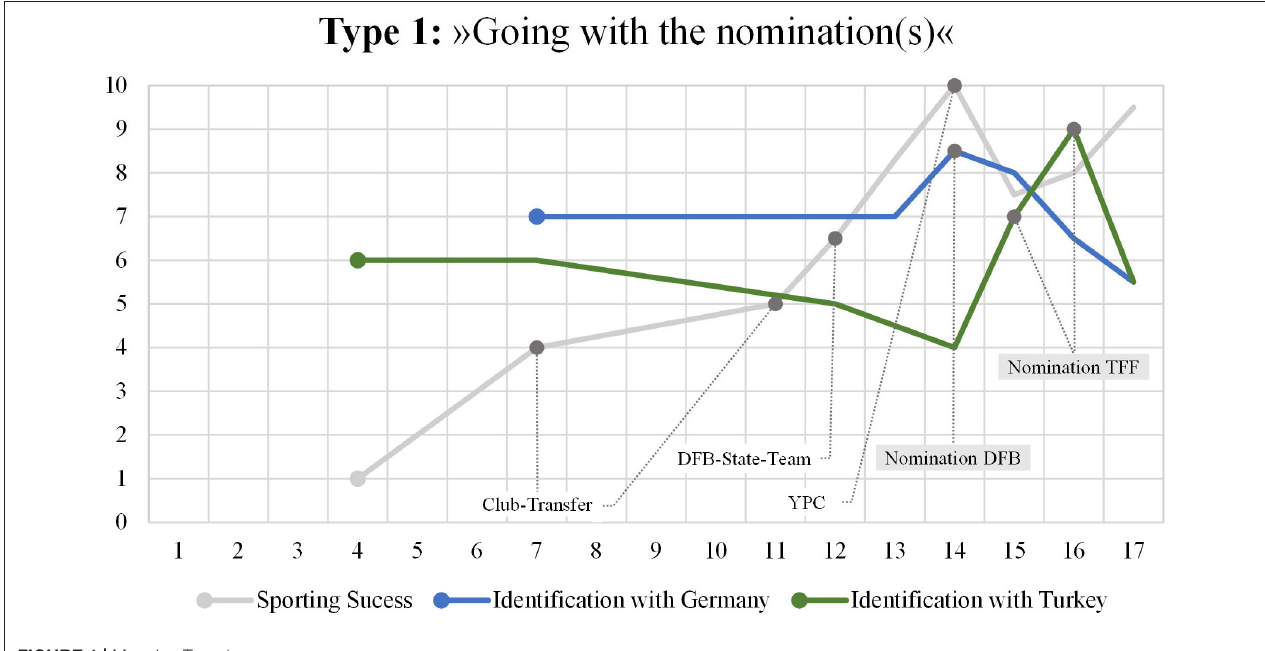
FIGURE 1 | Mapping Type